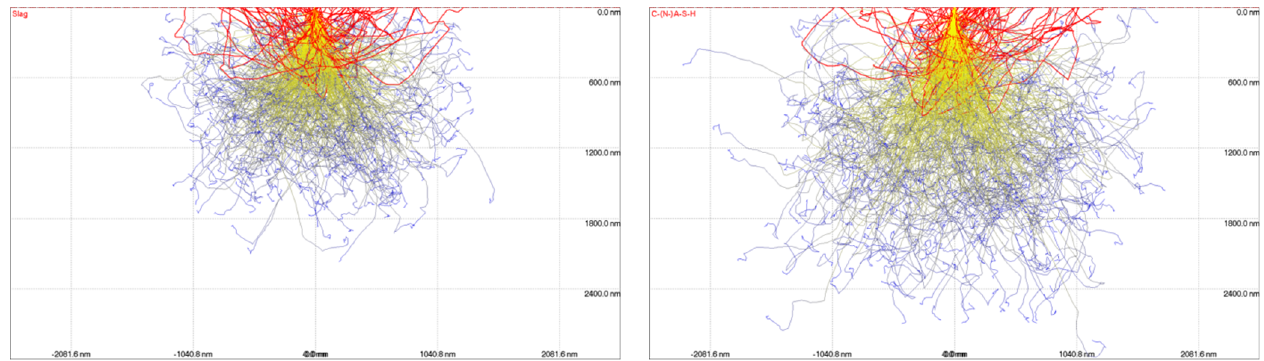
Figure 4. Monte Carlo simulation of the penetration of 1000 electrons accelerated at 15 kV in a beam radius of 10 nm into a GBFS ( left ) and the C-(N-)A-S-H gel ( right ). The red trajectories are back-scattered electrons, which result from elastic scattering events. Inelastic scattering events cause a reduction of electrons’ energy until the eventual disappearance in the specimen bulk. Yellow trajectories represent high-energy trajectories, and blue represents low-energy trajectories.